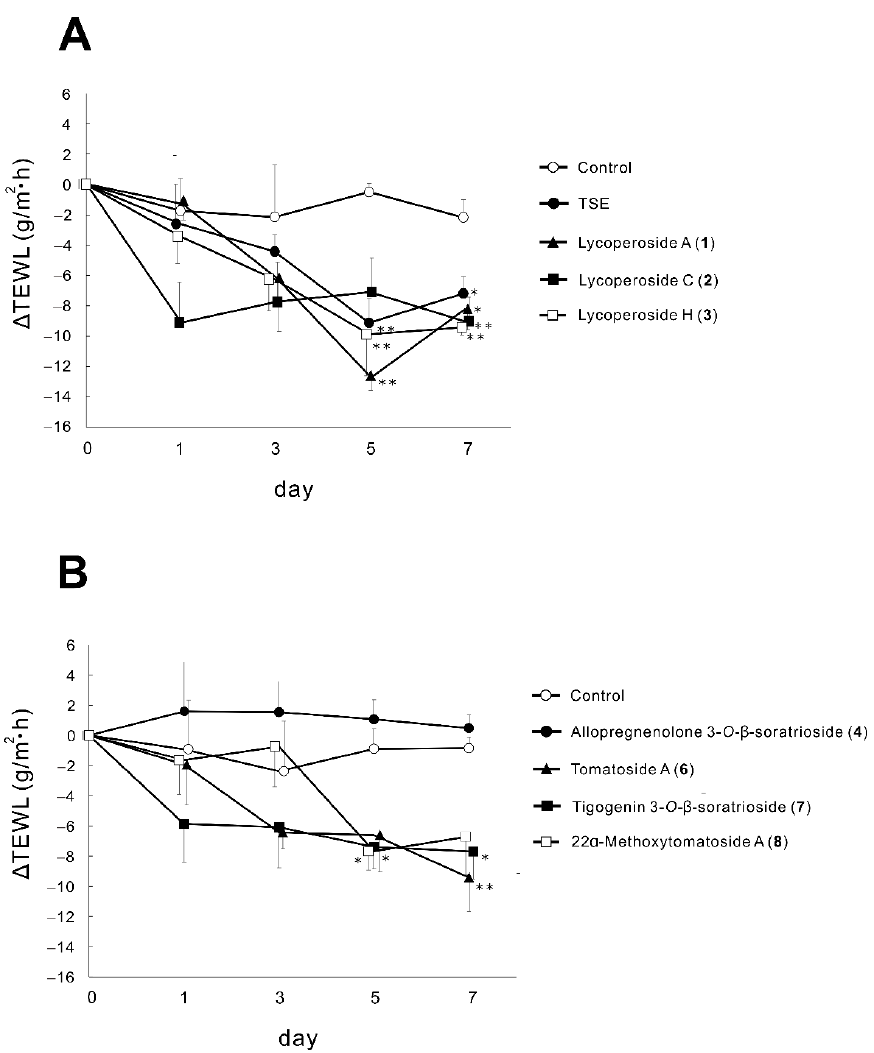
Figure 2. Effects of TSE and tomato seed saponins ( 1 – 4 , 6 – 8 ) on TEWL in RHEK models. RHEK models were treated with each sample (( A ) TSE: 10 µg/mL, 1 – 3 : 10 µM, ( B ) 4 – 8 : 10 µM) for 7 days. TEWL measurements were performed on days 0, 1, 3, 5, and 7 using Tewitro TW24. Data are expressed as mean ± SE ( n = 4). * p < 0.05, ** p < 0.01 vs. control.